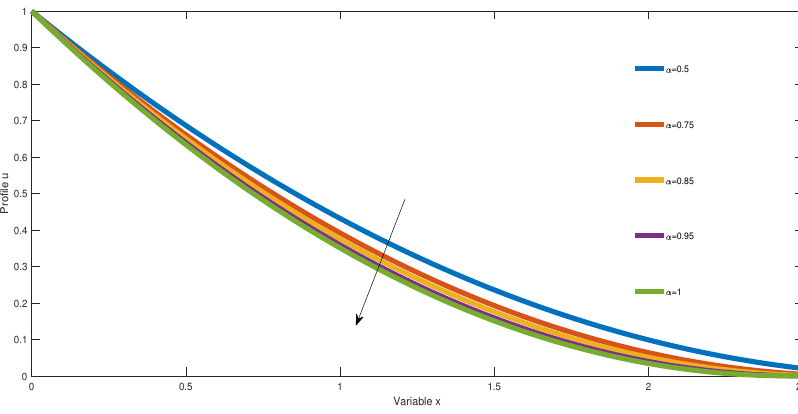
Figure 2. Profiles with different values of the fractional order.